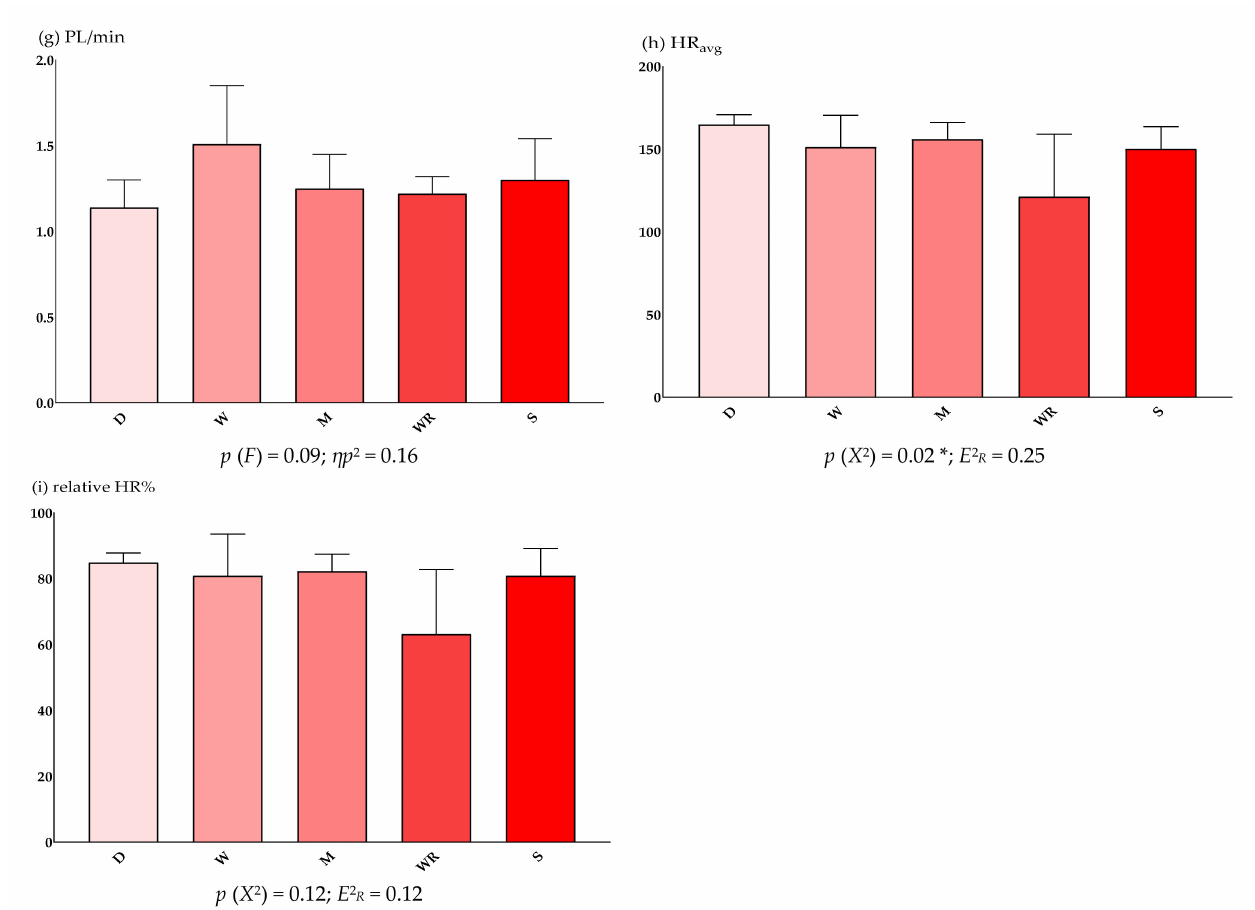
Figure 3. Descriptive and inferential results of the official matches according to specific player position. Note: X 2 = Kruskal–Wallis H Test; E 2 R = Epsilon-Squared Coefficient; F = One-factor ANOVA Test; η p2 = Partial Eta-Squared Index; eTL = external Training Intensity; min = Minute; m = Meter; Acc = Acceleration; Dec = Deceleration; HIA = High-Intensity Activity; PL = Player Load; iTL = internal Training Intensity; HR = Heart Rate; avg = Average; D = Defender; W = Wingback; M = Midfielder; WR = Winger; S = Striker. * p <